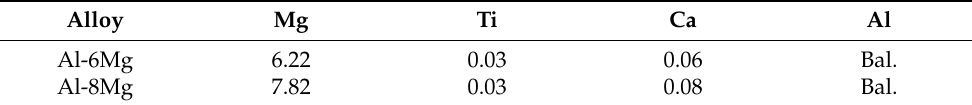
Table 1. Chemical composition (wt%) of Al-6Mg and Al-8Mg.